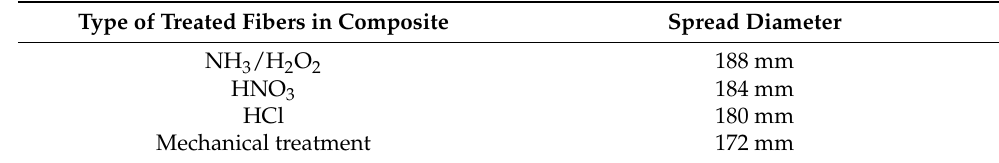
Table 5. Average slump flow of fabricated